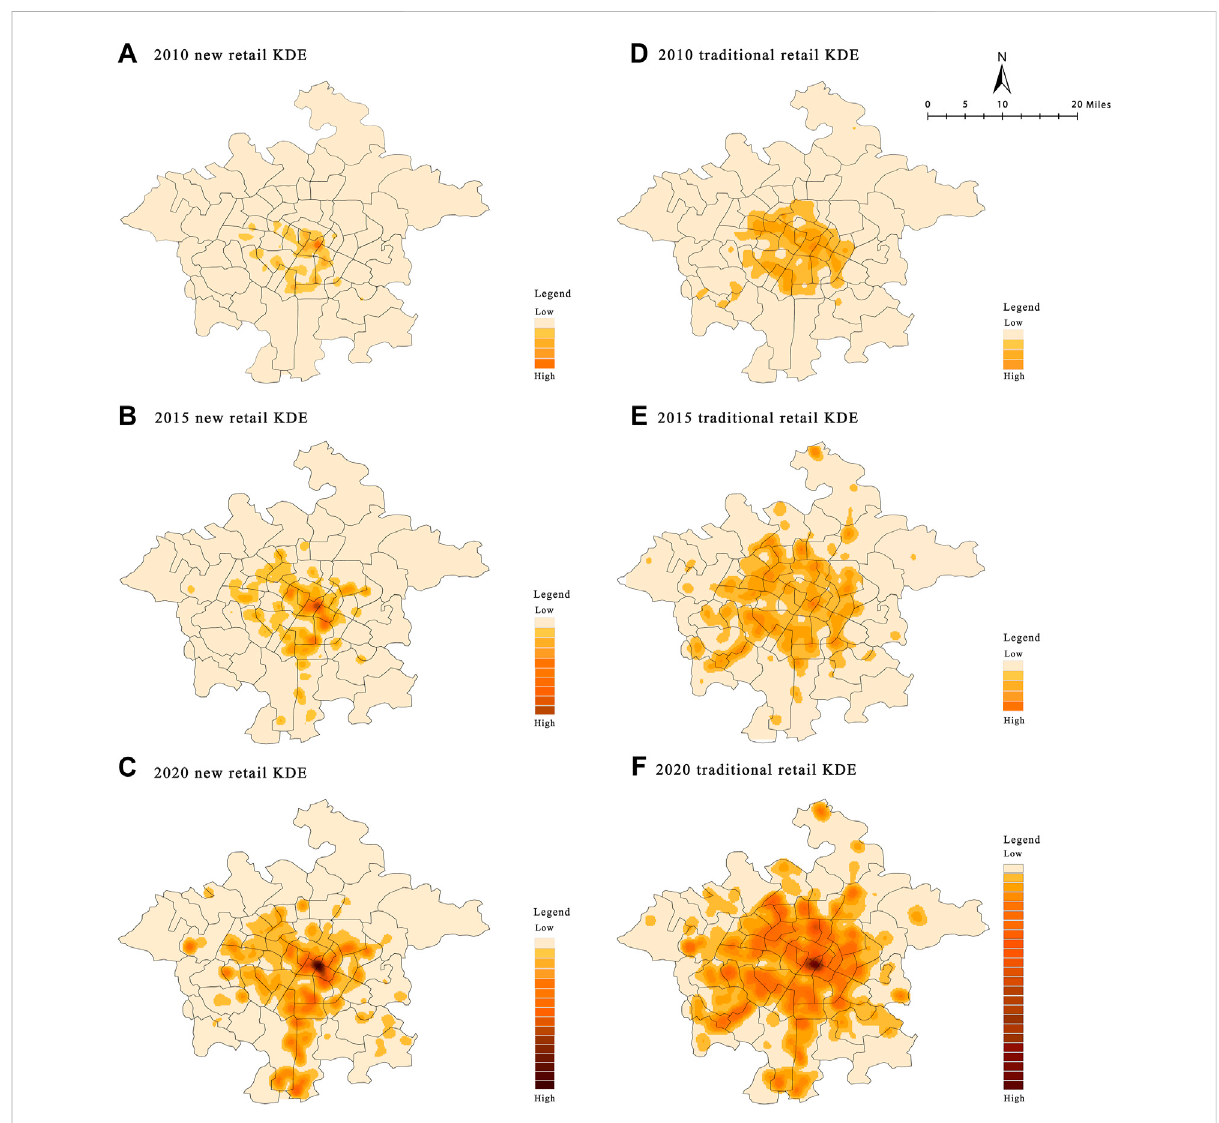
FIGURE 2 Kernel density map of the new and traditional retail places in Chengdu from 2010 to